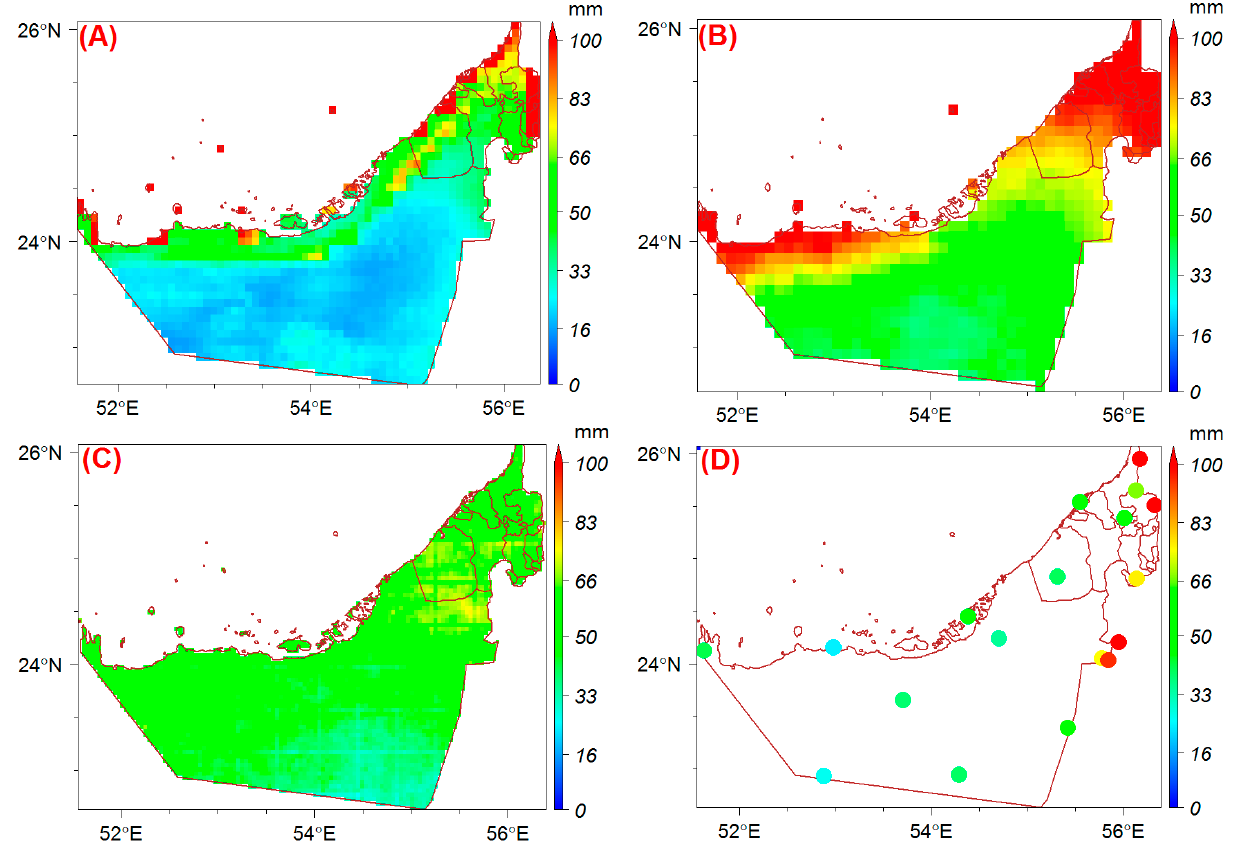
Figure 4. Spatial distribution of annual average rainfall for ( A ) CMORPH, ( B ) IMERG, ( C ) PERSIANN, and ( D ) rain gauges.